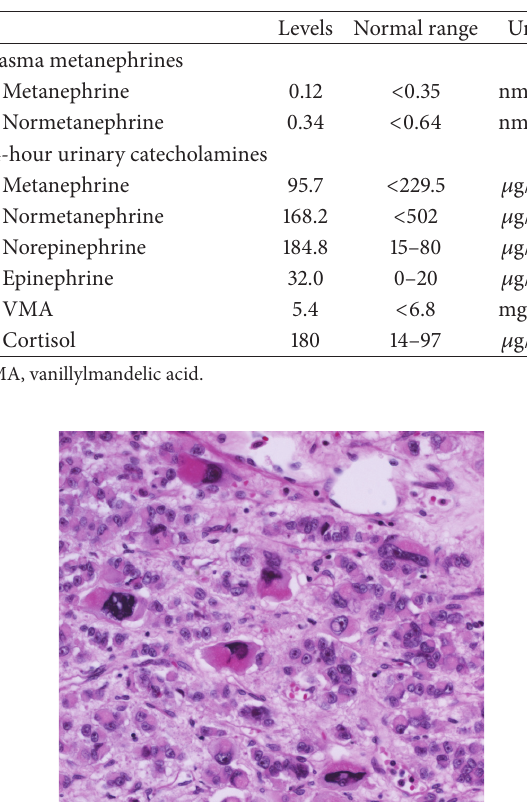
Figure 1: Abdominal computed tomography demonstrating a het- erogeneously enhanced mass, 14 × 12cm in diameter, with internal necrotic changes in the left adrenal region.